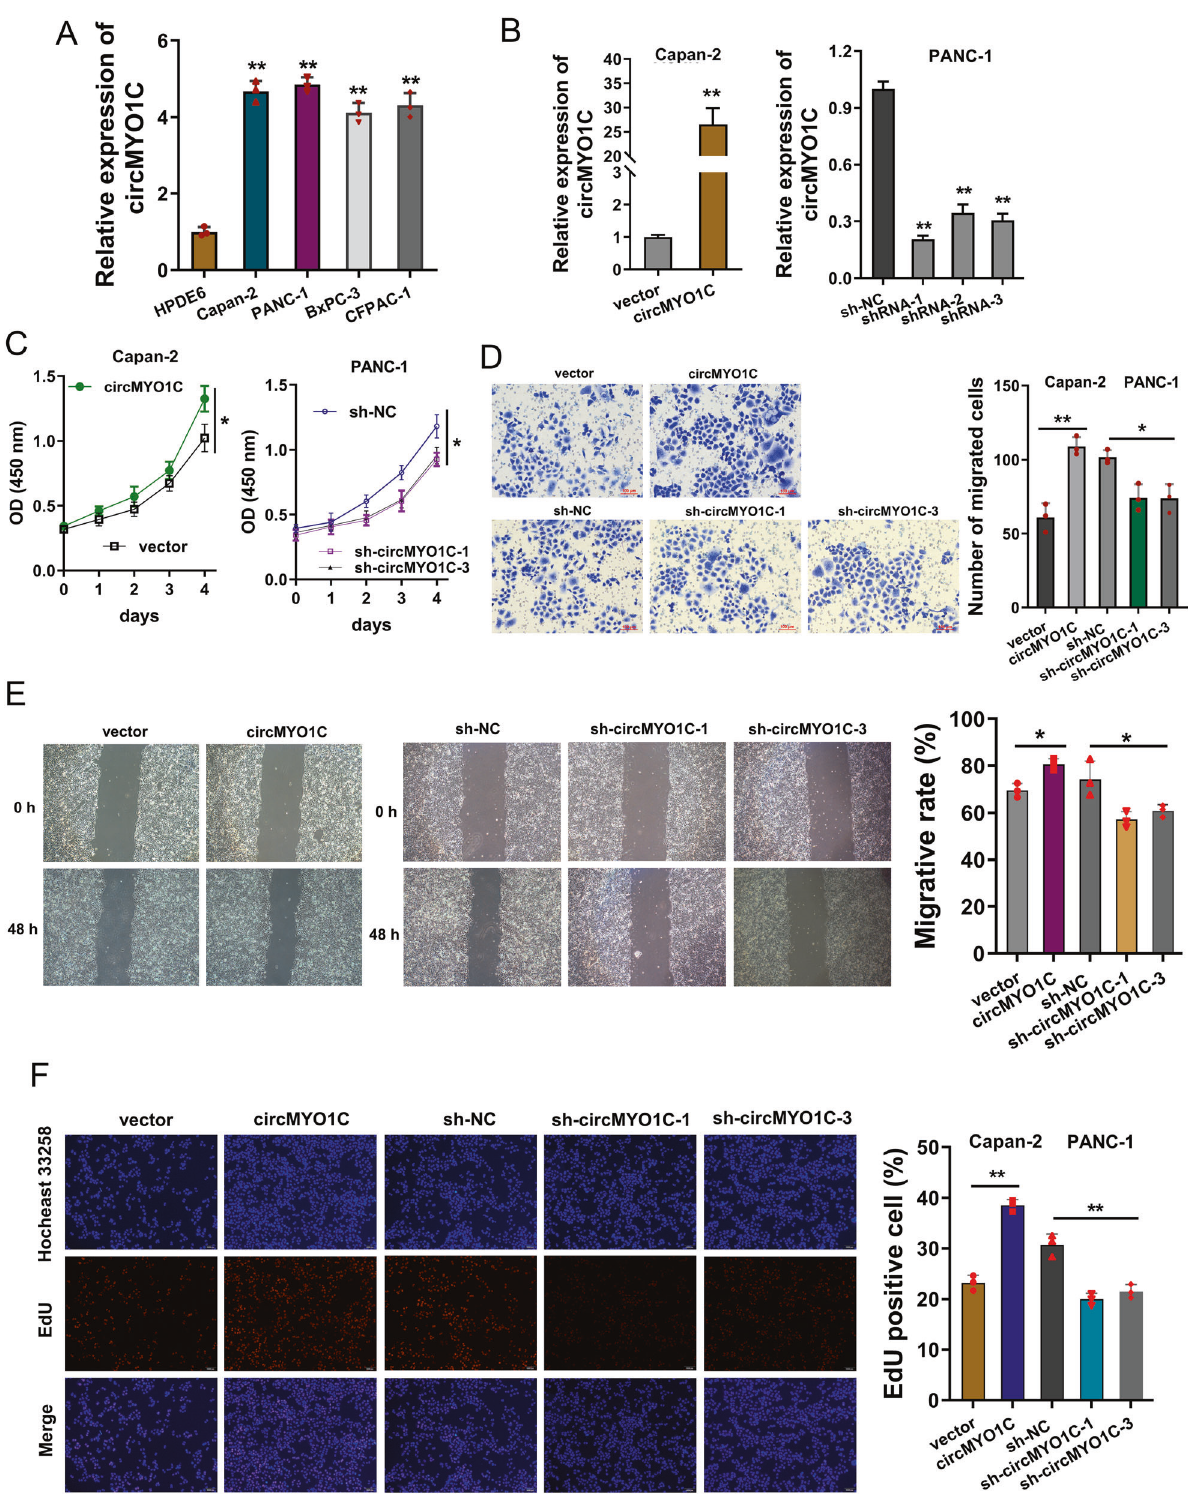
Fig. 2 circMYO1C promoted the proliferation and migration of PDAC cells. A RT-qPCR indicated the circMYO1C expression in PDAC cells (PANC-1, Capan-2, BxPC-3, CFPAC-1) normalized to normal cells (HPDE6). GAPDH acted as the internal control. B pcDNA vector (Capan-2 cell line) and short hairpin RNA (shRNA1/2/3) stable transfection (PANC-1 cell line) were performed following RT-qPCR quantitative analysis. C CCK- 8 viability assay was performed for PDAC cells ’ proliferation using short hairpin RNA (shRNA1/3) or circMYO1C overexpression. D Transwell migration assay was performed for the migrative ability of PDAC cells. Migrated cells were counted using short hairpin RNA (shRNA1/3) or circMYO1C overexpression. E Wound healing assay was performed for the migrated distance of PDAC cells after 48 h using short hairpin RNA (shRNA1/3) or circMYO1C overexpression. F Ethynyl-2-deoxyuridine (EdU) incorporation assay was performed for DNA synthesis using short hairpin RNA (shRNA1/3) or circMYO1C overexpression. EdU-positive cells were counted. * p < 0.05 and ** p < 0.01. Cell Death and Disease (2023)